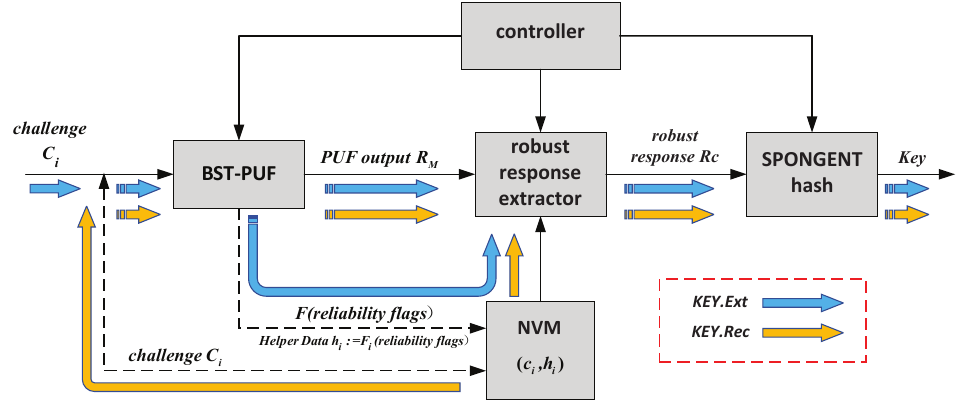
Figure 8. KEY . Ext / KEY . Rec